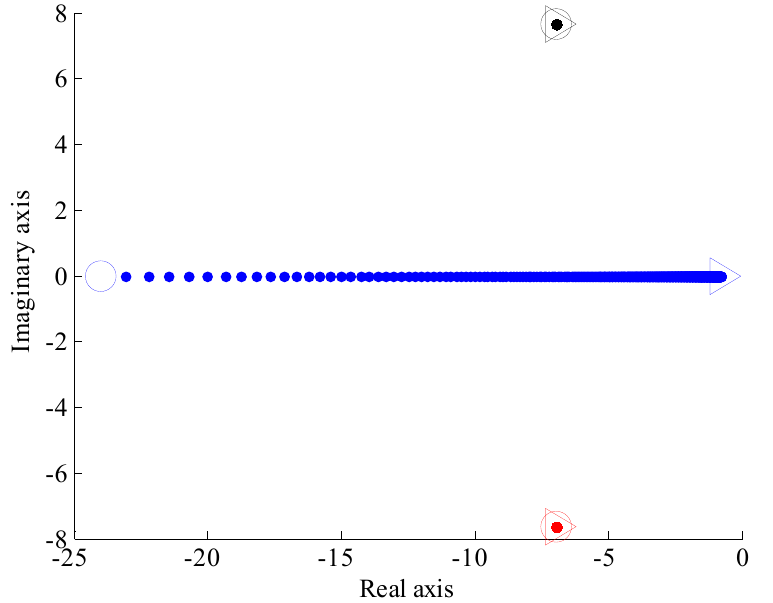
Figure 13. Location of the poles for the assistive toilet system for a virtual mass m v varying from 5 kg (circle) to 150 kg (triangle), c v = 120 Ns/m, T = 0.08 s, K p = 50.